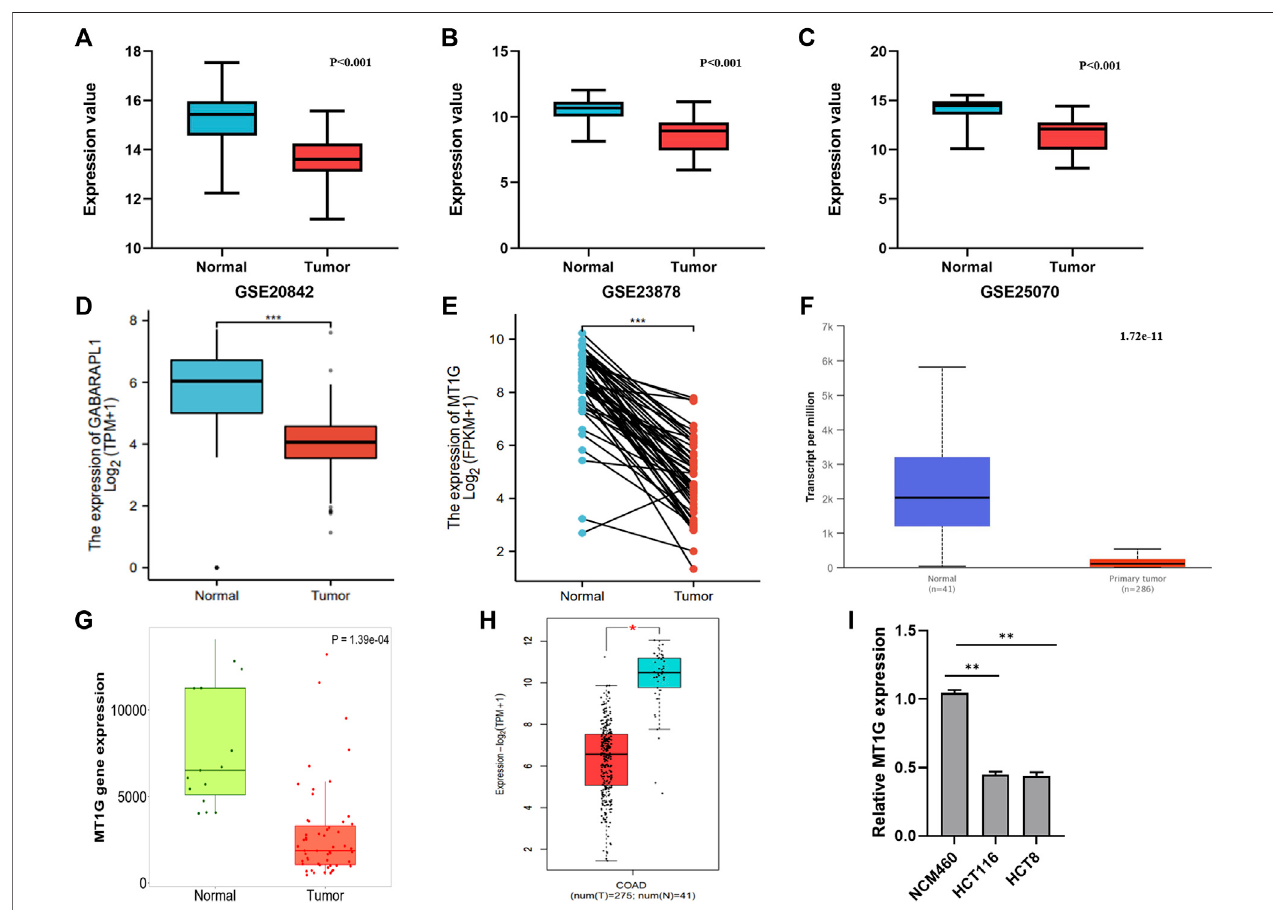
FIGURE 3 | Expression levels of MT1G veri fi ed in CRC tissues and cells. (A – H) Comparison of the MT1G expression between CRC and normal controls from (A) GSE20842, (B) GSE23878, (C) GSE25070, (D) paired TCGA-CRC, (E) unpaired TCGA-CRC, (F) UALCAN, (G) TNMplot, and (H) GEPIA2. (I) Low expression ofMT1G was detected by qPCR. * p < 0.05; ** p < 0.01; and *** p < 0.001.